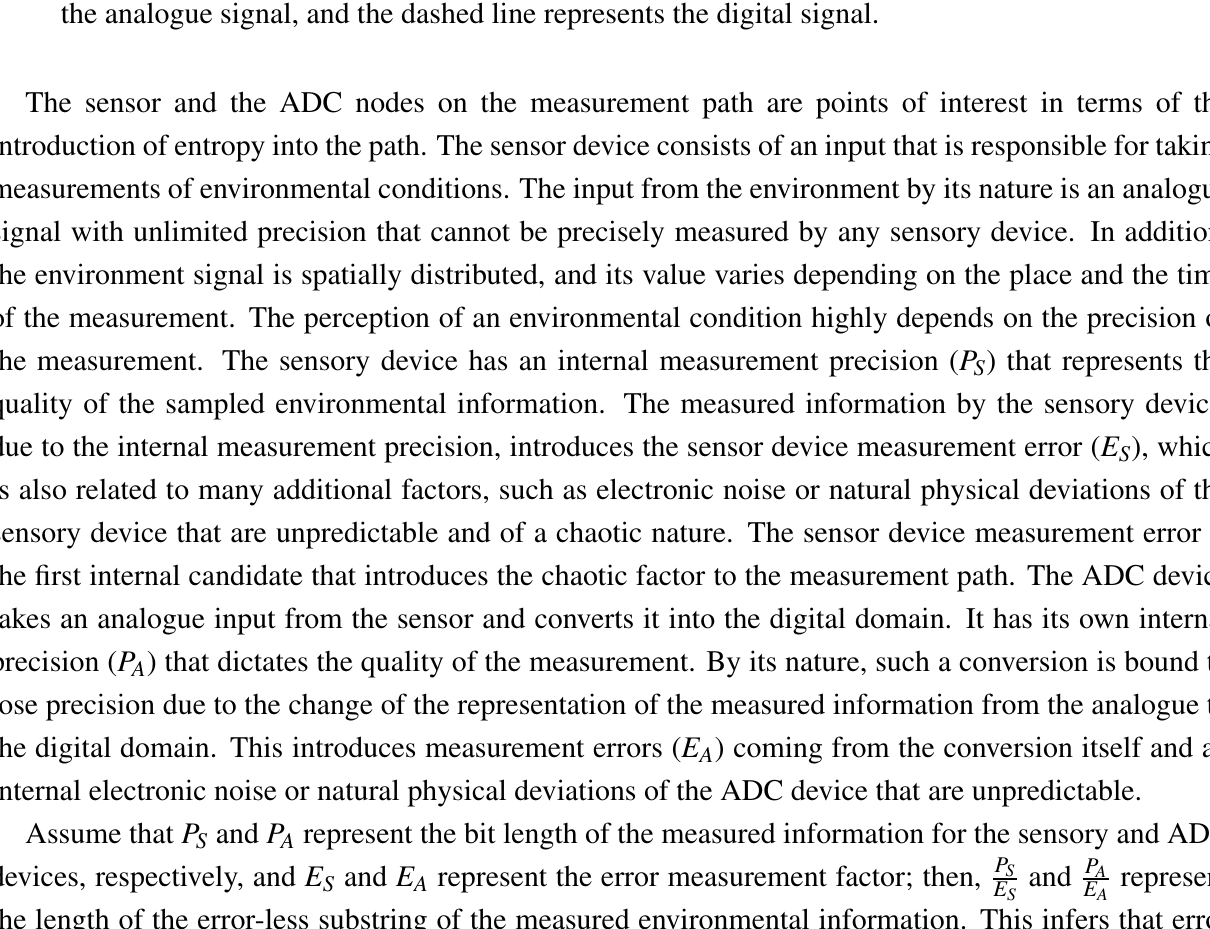
Figure 2. The simplified sensory measurement communication path. The P the precision of the sensor and ADC devices, respectively. The E measurement factor of the sensor and ADC devices, respectively. The straight line represents the analogue signal, and the dashed line represents the digital